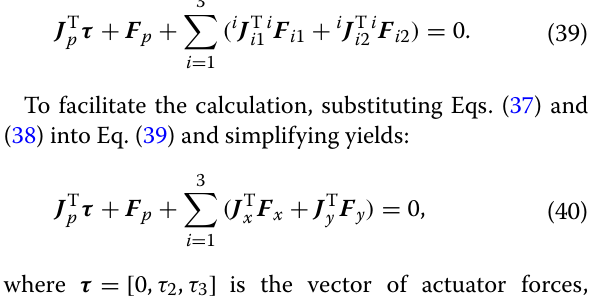
1) First mode: the velocity was 3.0 m/s with a load of 20 kg during flexion and extension. 2) Second mode: the velocity was 1.5 m/s without load- ing during abduction and adduction.